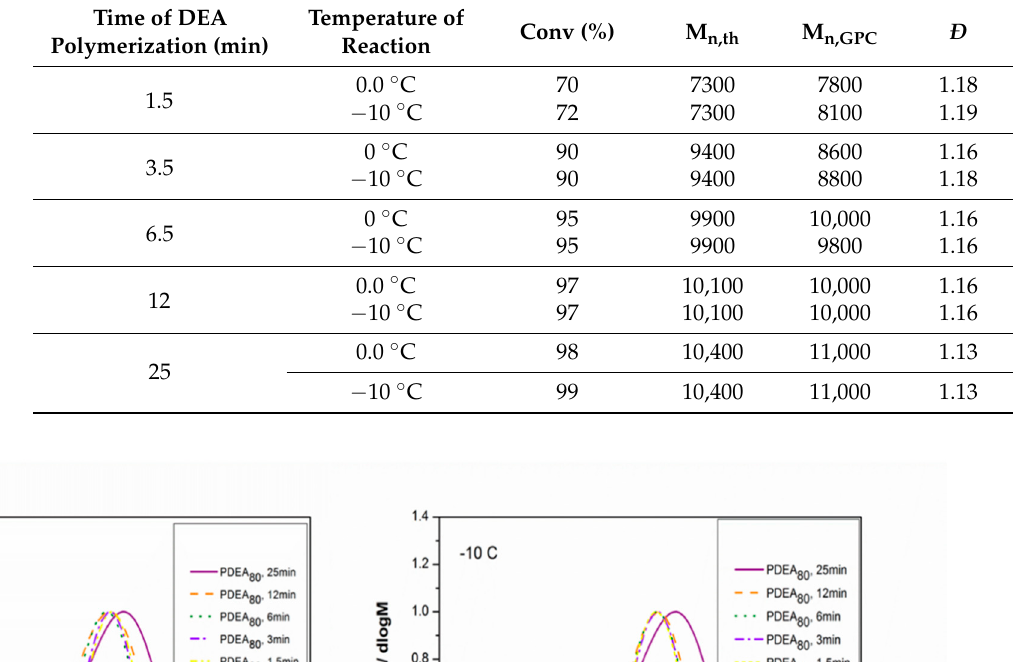
Table 3. Summary of characteristics of polymers of DEA obtained by Cu(0)-mediated polymerization.